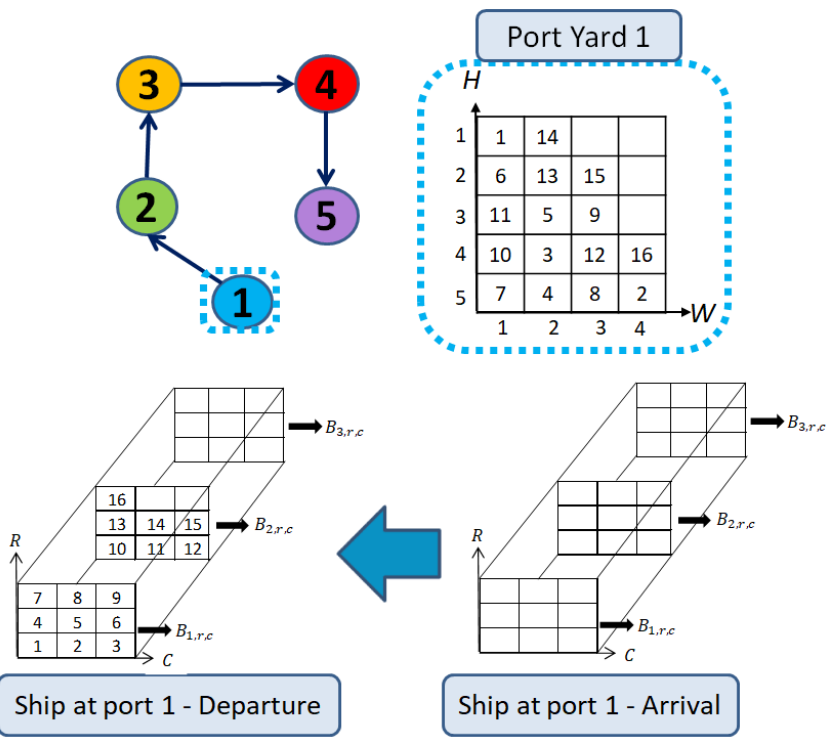
Figure 1. Loading flow at port 1.